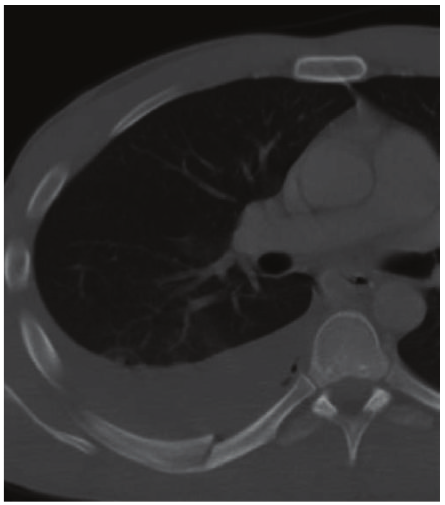
Figure 12: Rib fracture. Axial MDCT in bone window at the level of pulmonary trunk clearly demonstrates a fracture bone line of 8th posterior right arch associated with ipsilateral